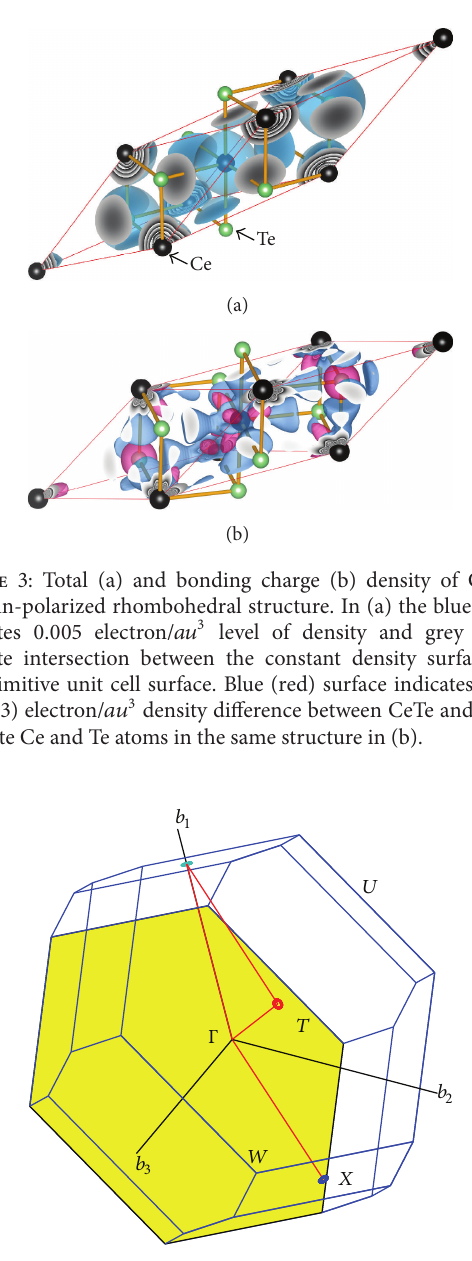
Figure 4: First Brillouine zone of the rhombohedral structure (the path of electronic band structure is indicated with the red